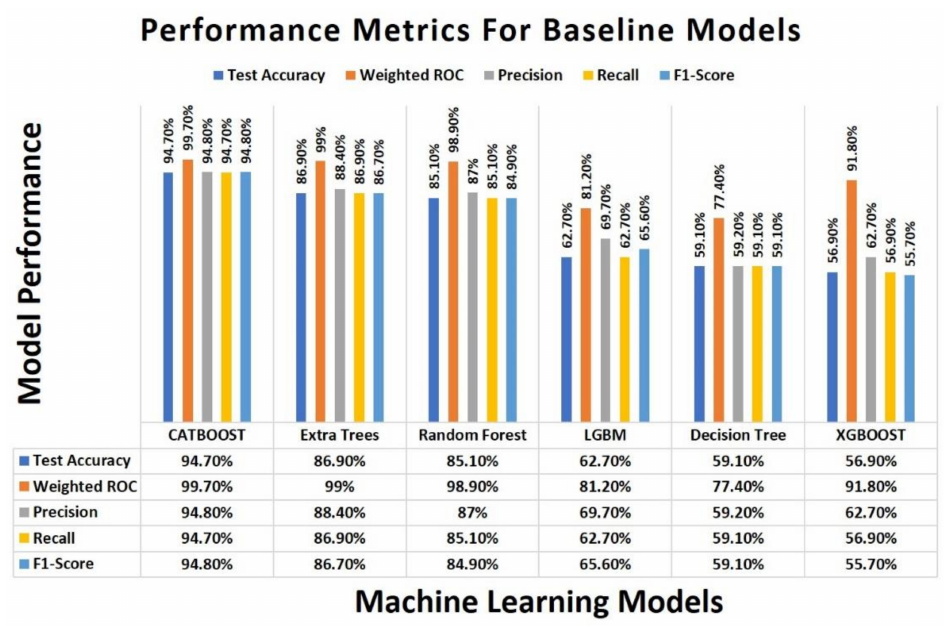
Figure 8. Baseline model performance comparison over all the performance metrics.